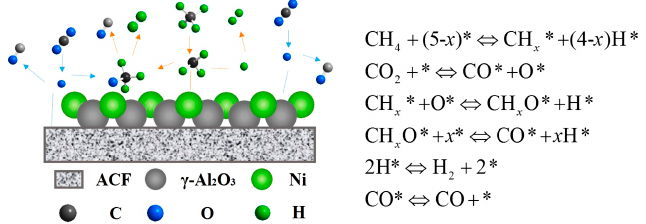
Figure 8. Schematic of elementary reaction of dioxide reforming of methane (DRM) with Ni– γ –Al 2 O 3 /ACF.